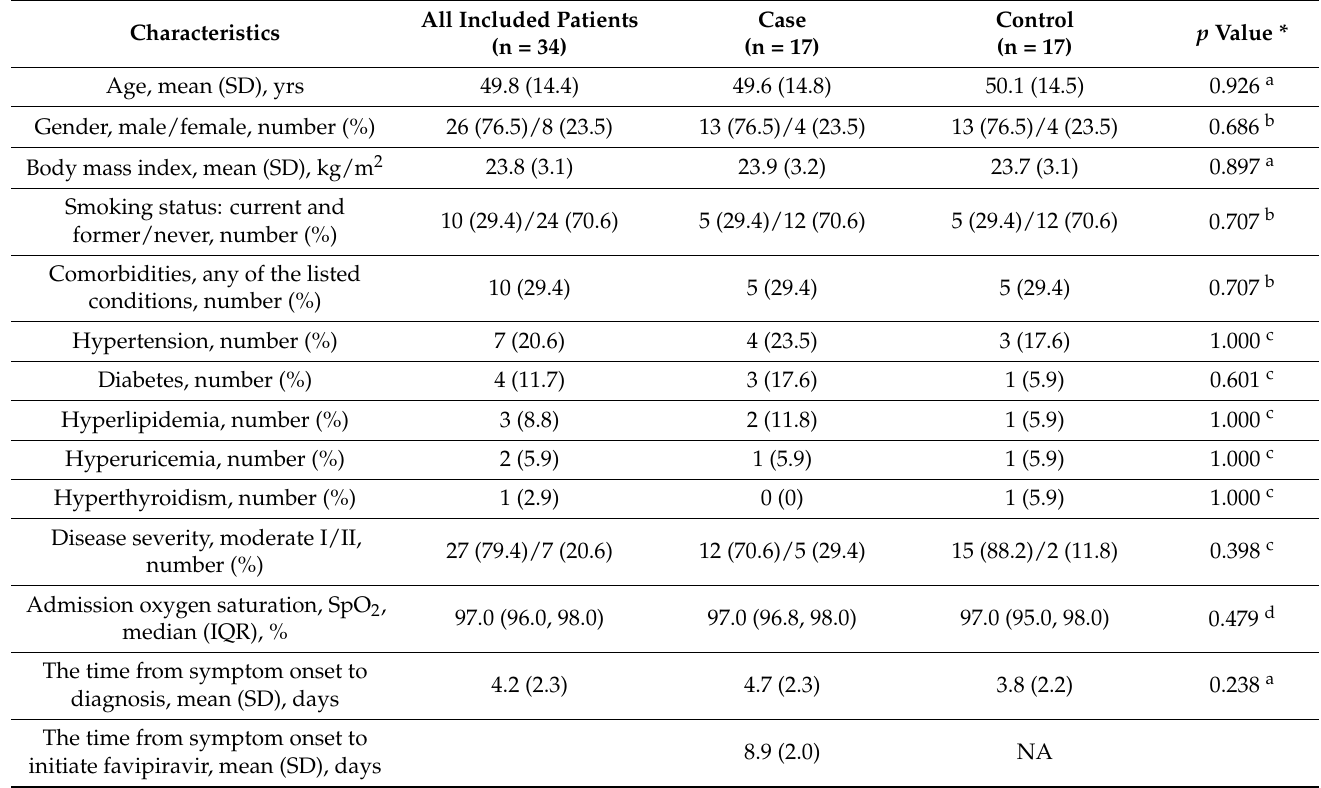
Table 1. Baseline characteristics on the admission of included cases and matched controls diagnosed as moderate